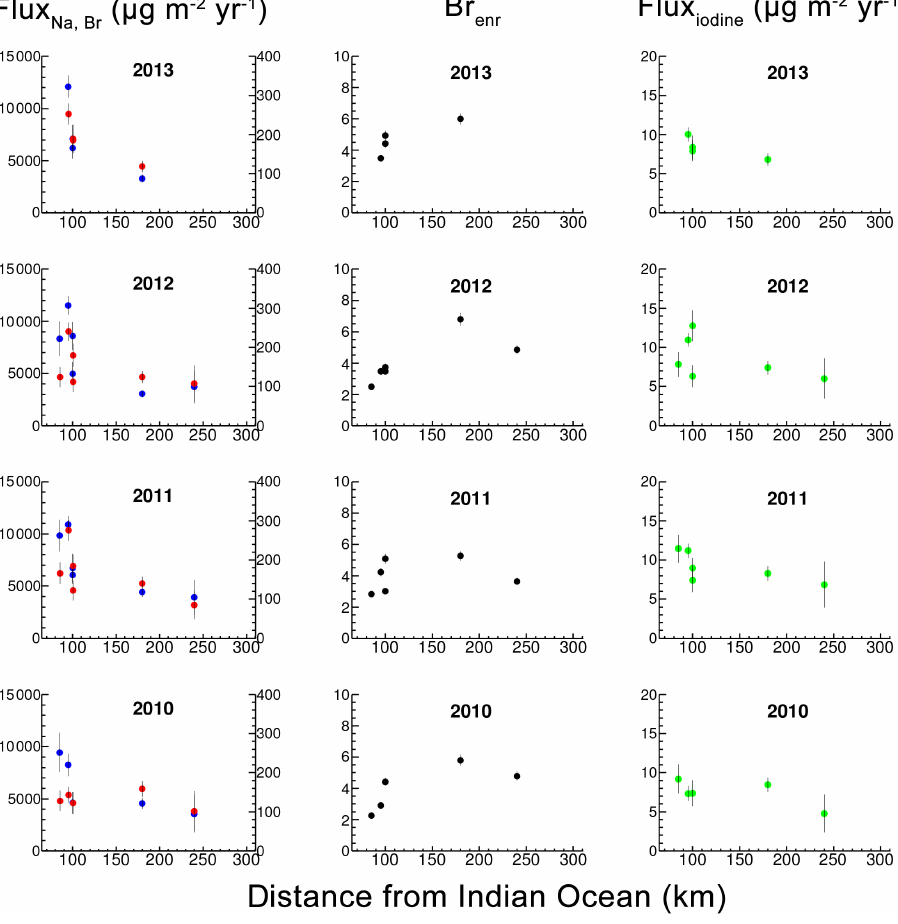
Figure 9. Mean annual fluxes of sodium (blue, left axes), bromine (red, right axes), iodine (green) and bromine enrichment values (black) as a function of distance from the Indian Ocean. Each dot represents a location along the